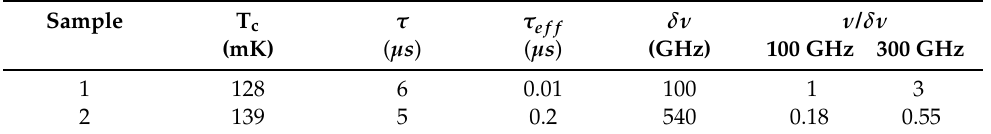
Table 1. Main figures of merit deduced for the nano-TES . The time constant τ , the pulse recovery time τ ef f , the frequency resolution δν , and the resolving power ν / δν (at 100 and 300 GHz) are reported for the two fabricated